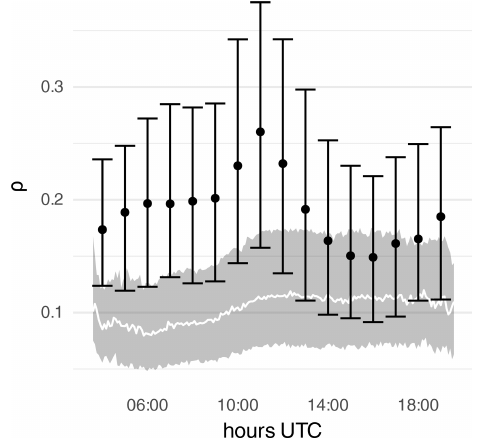
Figure 10. As Fig. 8, but for ρ and without separation by radars.